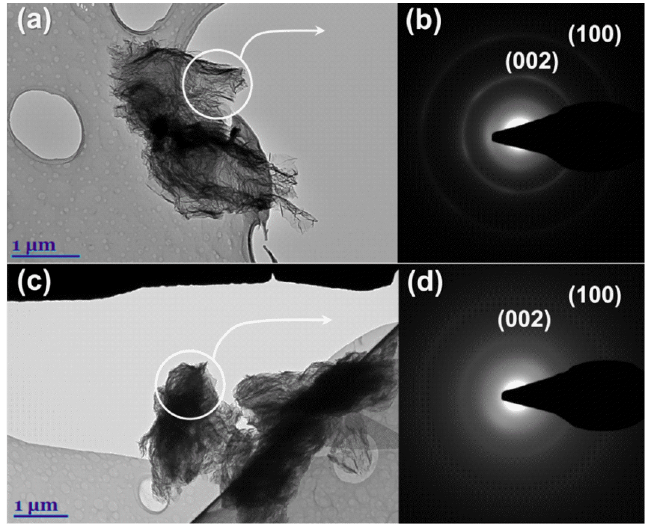
Figure 7. TEM images of—rGO 1 _10 ( a ) and rGO 2 _10 ( c ). SAED patterns of rGO 1 _10 ( b ) and rGO 2 _10 ( d